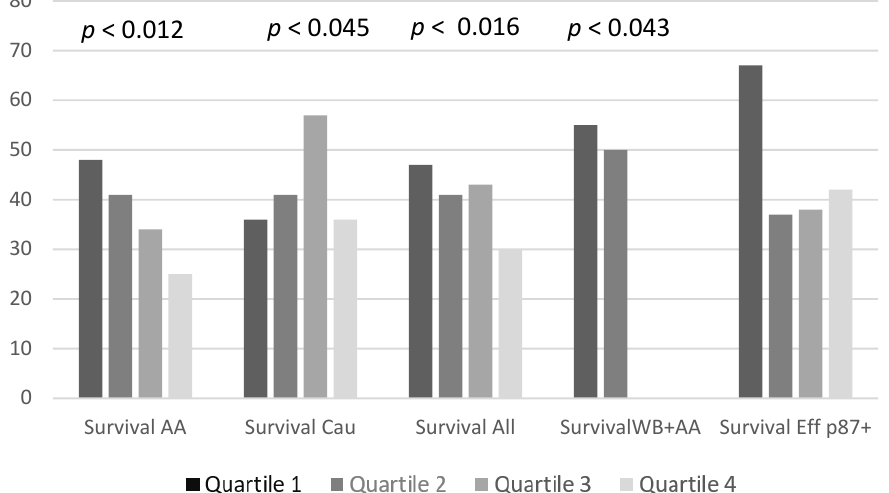
Figure 6. Bar diagram of overall survival by FERAD ratio quartile. Abbreviations: AA—African American; Cau—Caucasian; Eff—Effluent; WB—Western blot. Table 4. Differences in Survival.